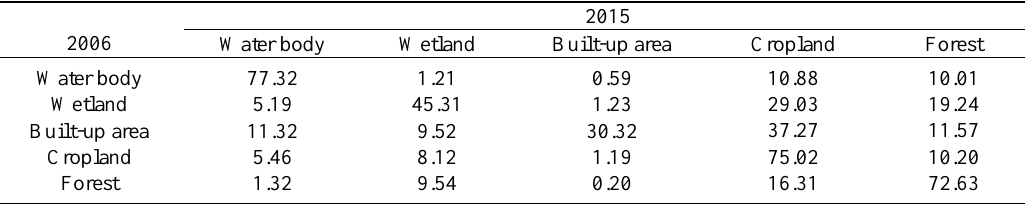
Table 2. Land cover transfer matrix of Dongting Lake from 2006 to 2015(%)